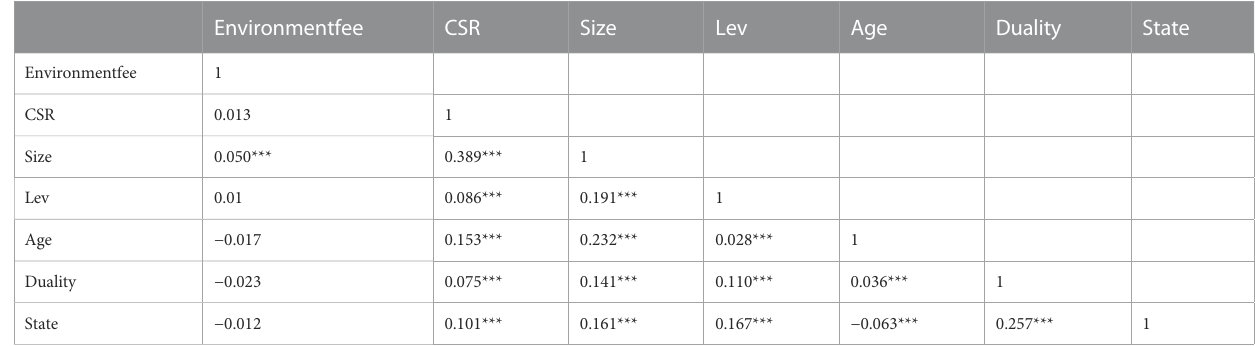
TABLE 3 Pair-wise correlation .